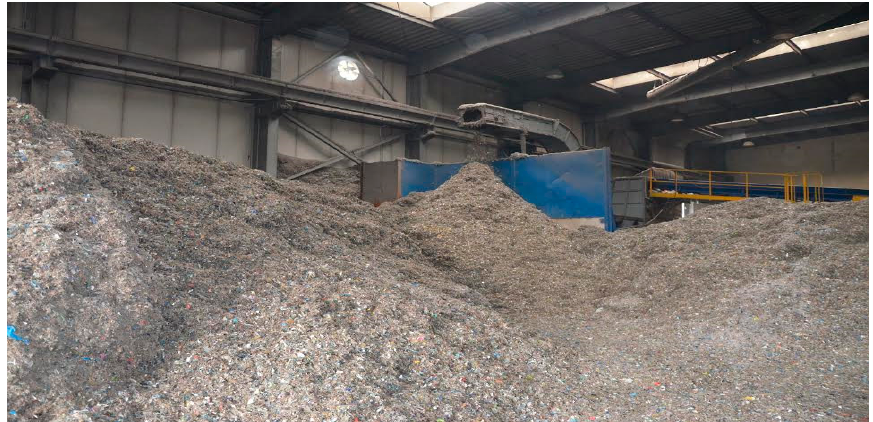
Figure 1. Alternative fuel storage method in the production and storage hall (own photo).